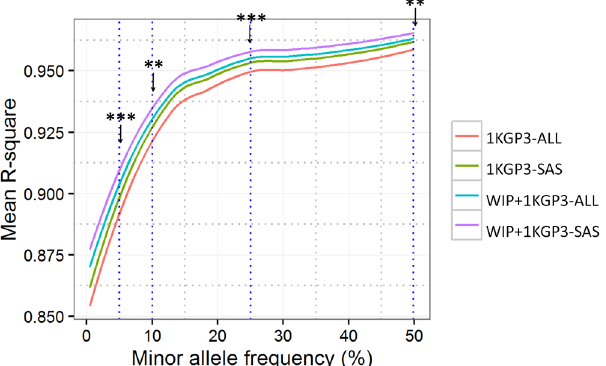
Figure 4. Comparison of imputation accuracy using 1000 Genomes phase 3 (1KGP3-ALL), Western-Indian panel (WIP) and 1000 Genomes phase3-SASonly (1KGP3-SAS) reference panels. Affy 6.0 SNPs from 1880 individuals from Western India were imputed at khap 3000 using 1KGP3-ALL and 1KGP3-SAS and average r-square values were plotted against each minor allele frequency (MAF) bin. Two-tailed paired-end TTEST was conducted for the mean r-square values at given MAF-bins between 1KGP3-ALL and WIP + 1KGP3- SAS panel imputed SNPs. ‘p’ values of < 0.001 and 0.01 are indicated by *** and ** respectively. Results are restricted to chromosome 20 only. 1KGP3-ALL, The 1000 Genomes phase 3 reference panel; 1KGP3-SAS, The 1000 Genomes phase 3 panel with only South Asian component; WIP + 1KGP3-ALL, merged panel of WIP and 1KGP3-ALL; WIP + 1KGP3-SAS, merged panel of WIP and